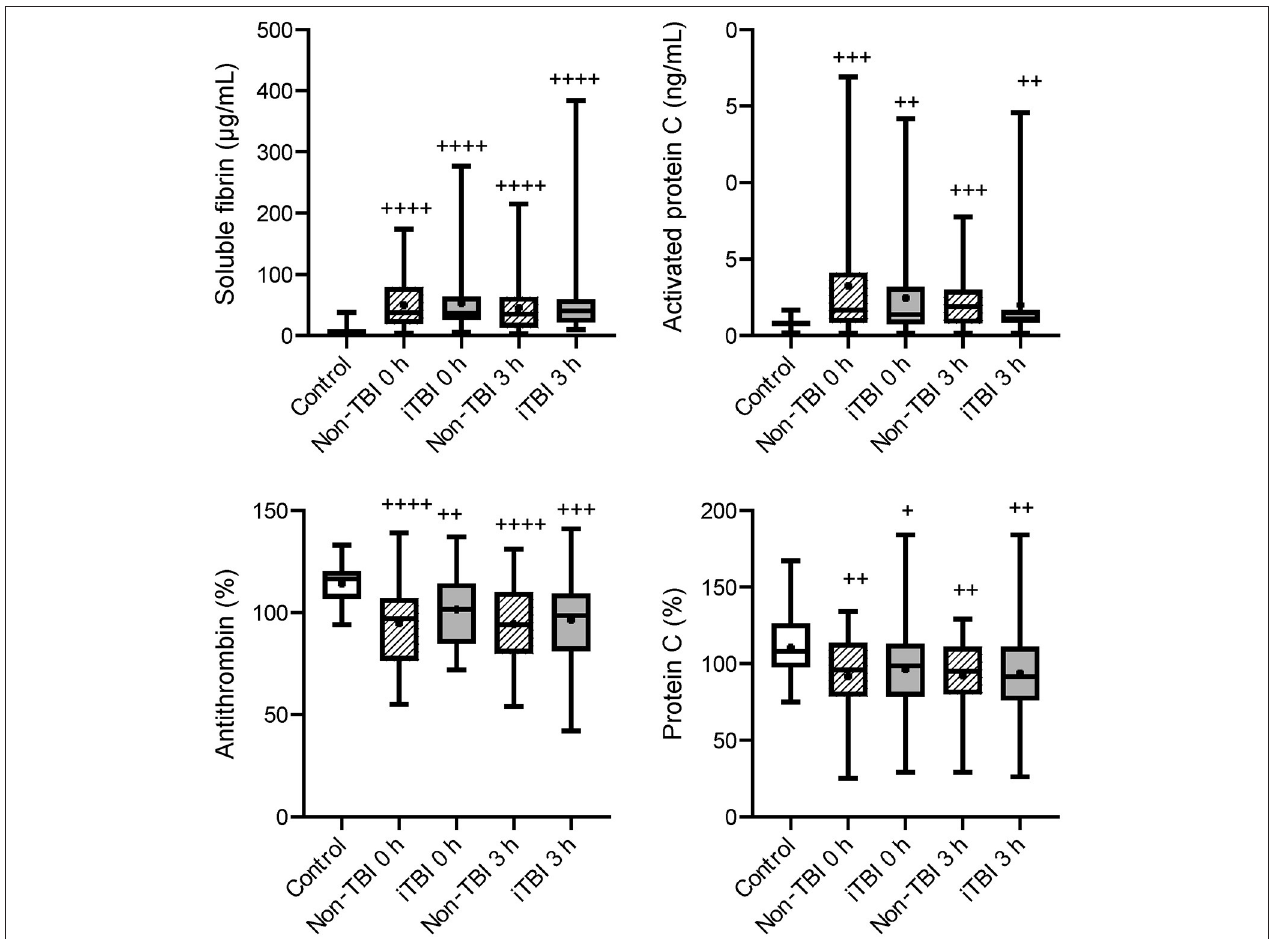
FIGURE 1 | Serial changes in the coagulation-related molecular markers. Healthy controls (white box), non-traumatic brain injury (TBI) (hatched boxes), and isolated TBI (iTBI) (gray boxes) at presentation to the emergency department (0h) and 3h after hospital arrival (3h). The horizontal bars in the box indicate the median (middle) and interquartile ranges (upper 25% and lower 75%). Black boxes are mean values. + p < 0.05 vs. healthy controls; ++ p < 0.01 vs. healthy controls; + + + p < 0.001 vs. healthy controls; + + ++ p < 0.0001 vs. healthy controls. None of the markers significantly differed between the iTBI and non-TBI groups.